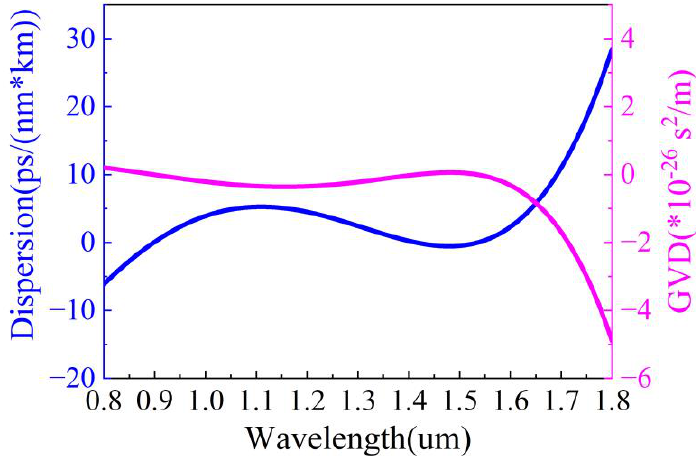
Figure 10. Simulated dispersion and GVD of the investigated AR-HCF.